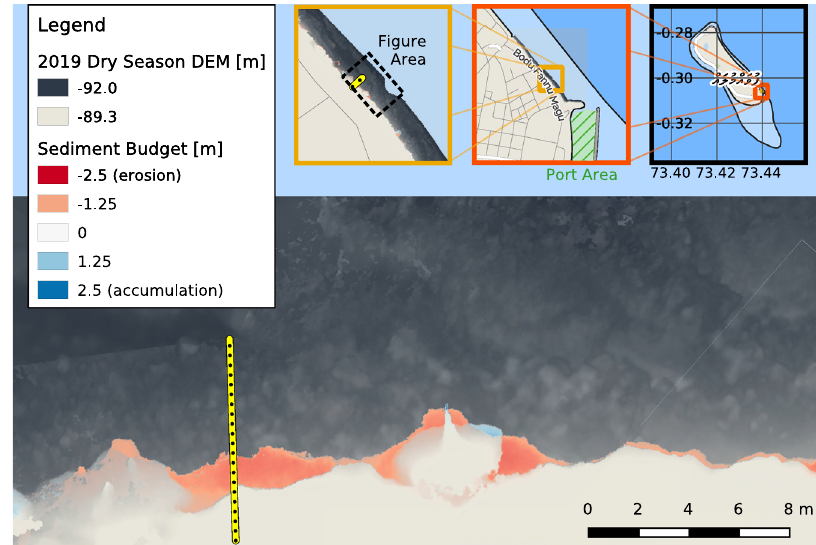
Fig. 3 Erosion adjacent to the port. The Digital Elevation Model (DEM) of the dry season 2019 on the southeastern coast of Fuvahmulah, adjacent to the seaport. The fi gure shows erosion (red) and accumulation (blue) when compared to the DEM of the dry season 2017. The yellow dotted line is the most southern transect of this study with cross-sectional differences of ~1.33 m (see Fig. 2d). Maps contain data from fi eld measurements, mini maps also